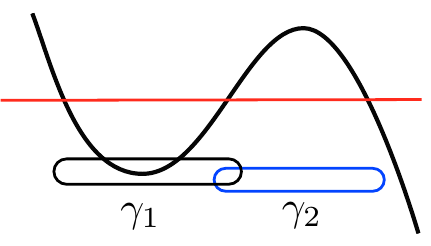
Figure 1 . The WKB cycles for the Delabaere-Pham